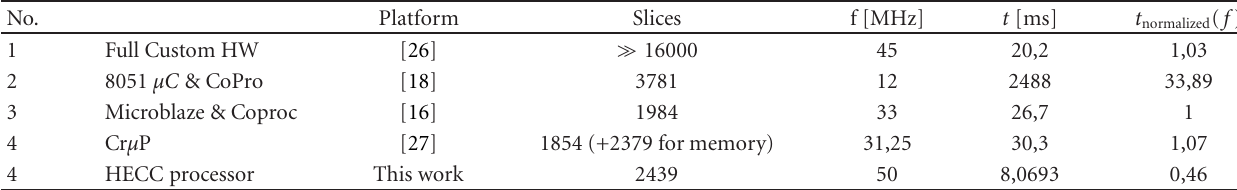
Table 3: Duration of 1 scalar multiplication k · P